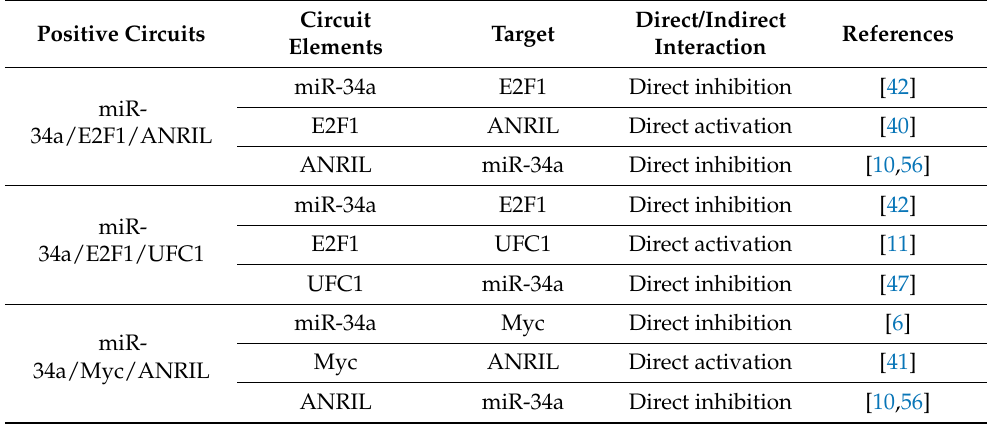
Table 3. The evidence of the biochemical interactions defining the biological positive circuits is well-characterized in the literature.